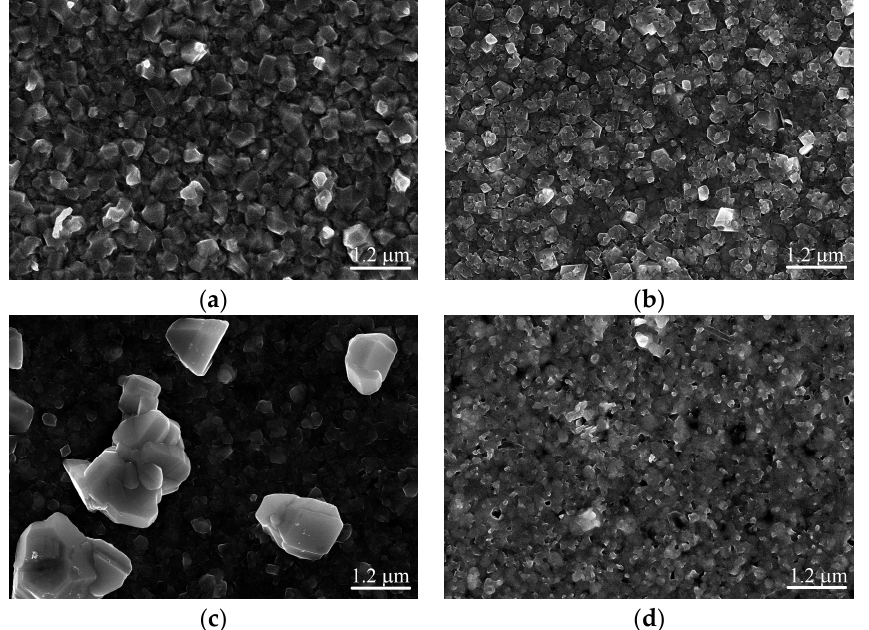
Figure 4. Surface SEM images of Ag and Mn co-doped Cu 2 ZnSnS 4 thin films with ( a ) Ag/(Ag + Cu) = 0; ( b ) Ag/(Ag + Cu) = 1/3; ( c ) Ag/(Ag + Cu) = 2/3; and ( d ) Ag/(Ag + Cu) = 1.